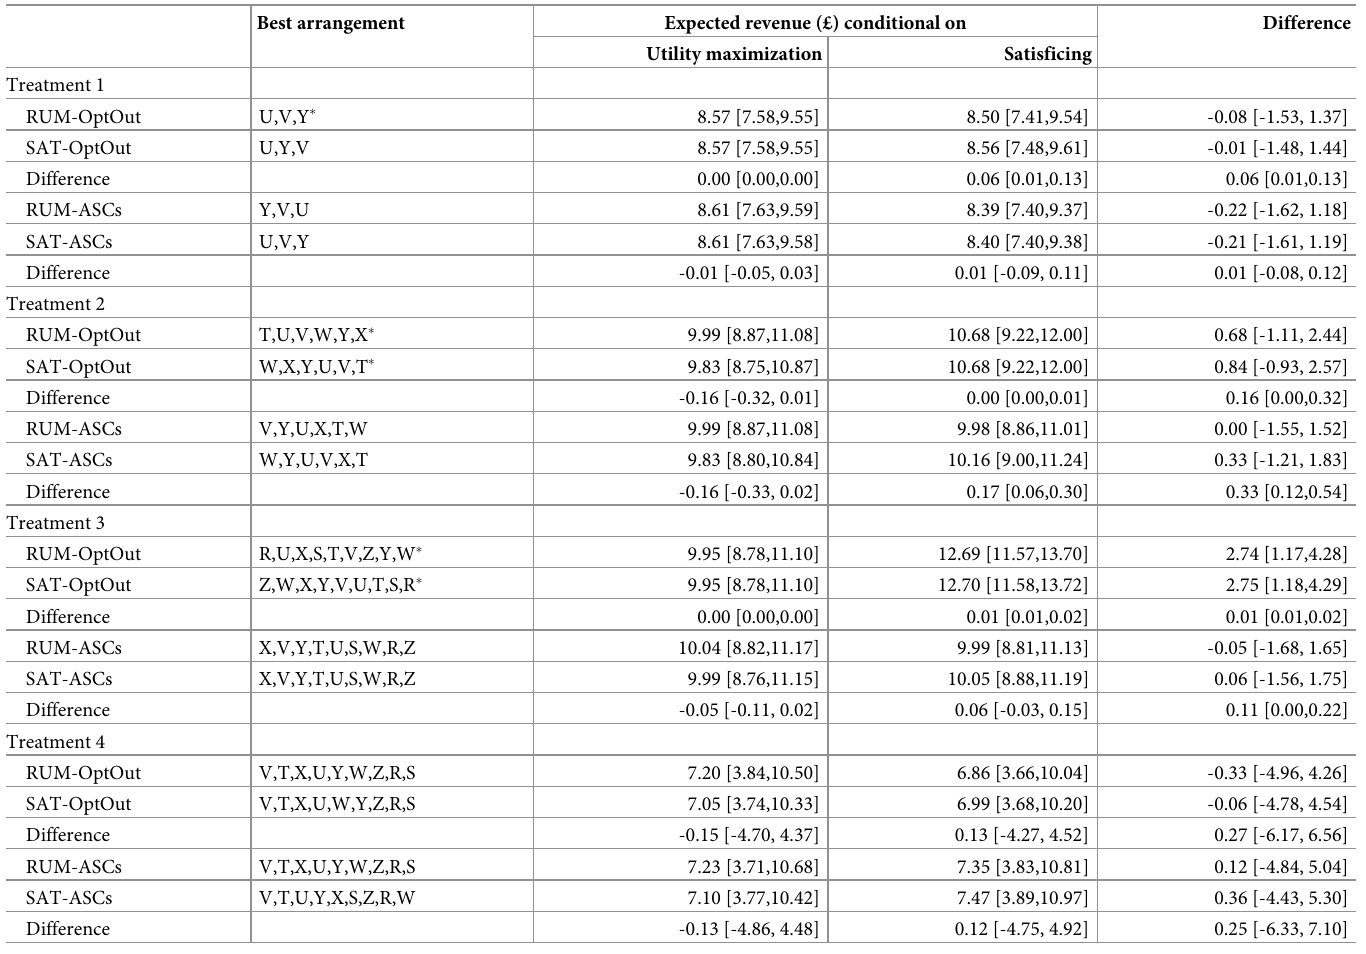
Table 10. Predictions or expected revenue and optimal arrangement for bottles R–Z (inferior